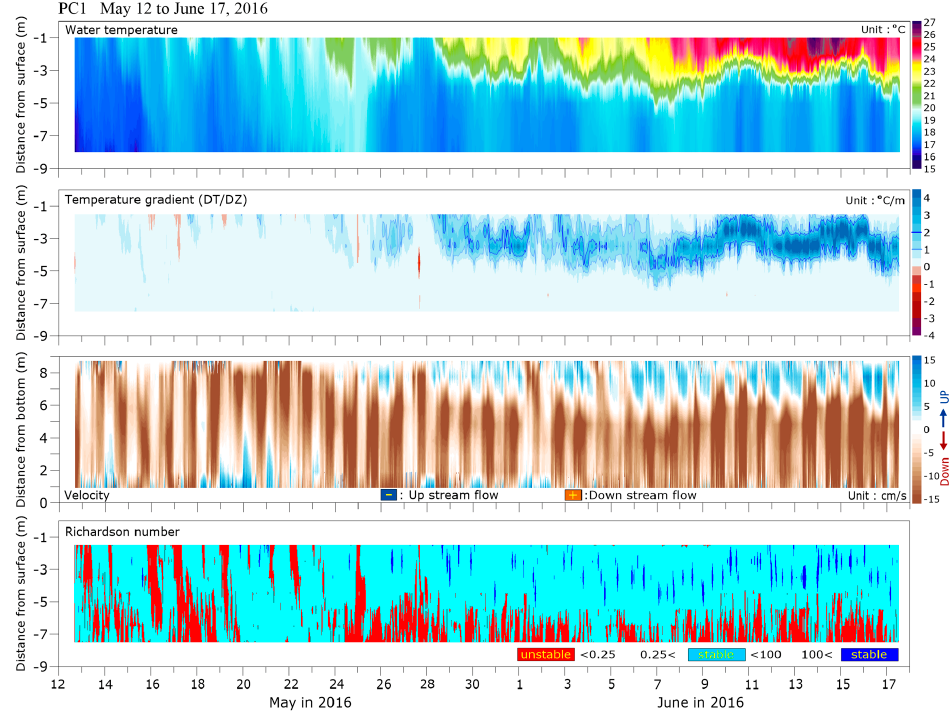
Figure 6. Profiles and time series of the water temperature, flow velocity, and Richardson number at PC1.